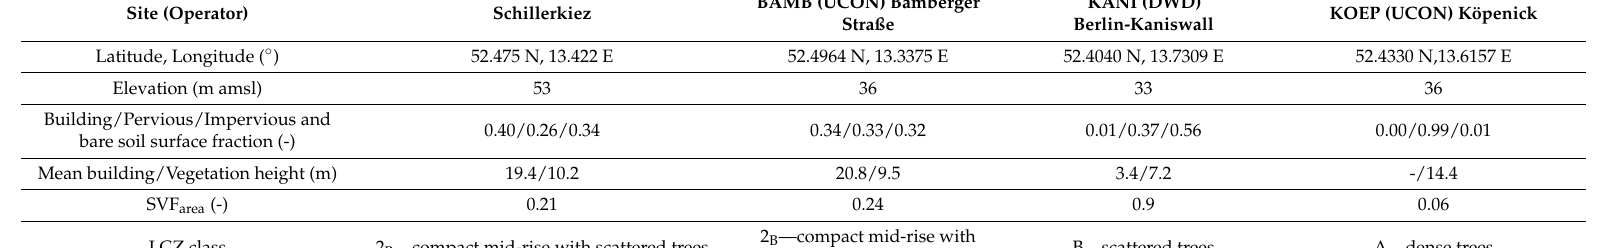
Table 1. Meta data for the study area Schillerkiez and measurement sites in other Local Climate Zones (LCZs). Land cover characteristics are given as spatial mean values for a 250 m radius around each site or for the complete area (Schillerkiez). The LCZ classification of SCHN is based on local expert knowledge and aerial photographs. UCON: Urban Climate Observation Network by Technische Universität Berlin, DWD: German Weather Service (Deutscher Wetterdienst), SVF area : areal mean sky view factor. © all aerial photographs [35], except SCHN (© [36]). The circle in the aerial photograph of the Schillerkiez serves for size comparison.